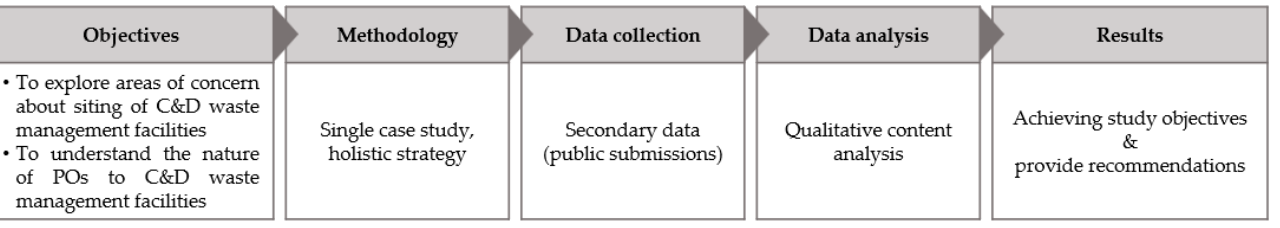
Figure 1. The overview of the research process. Source: authors.